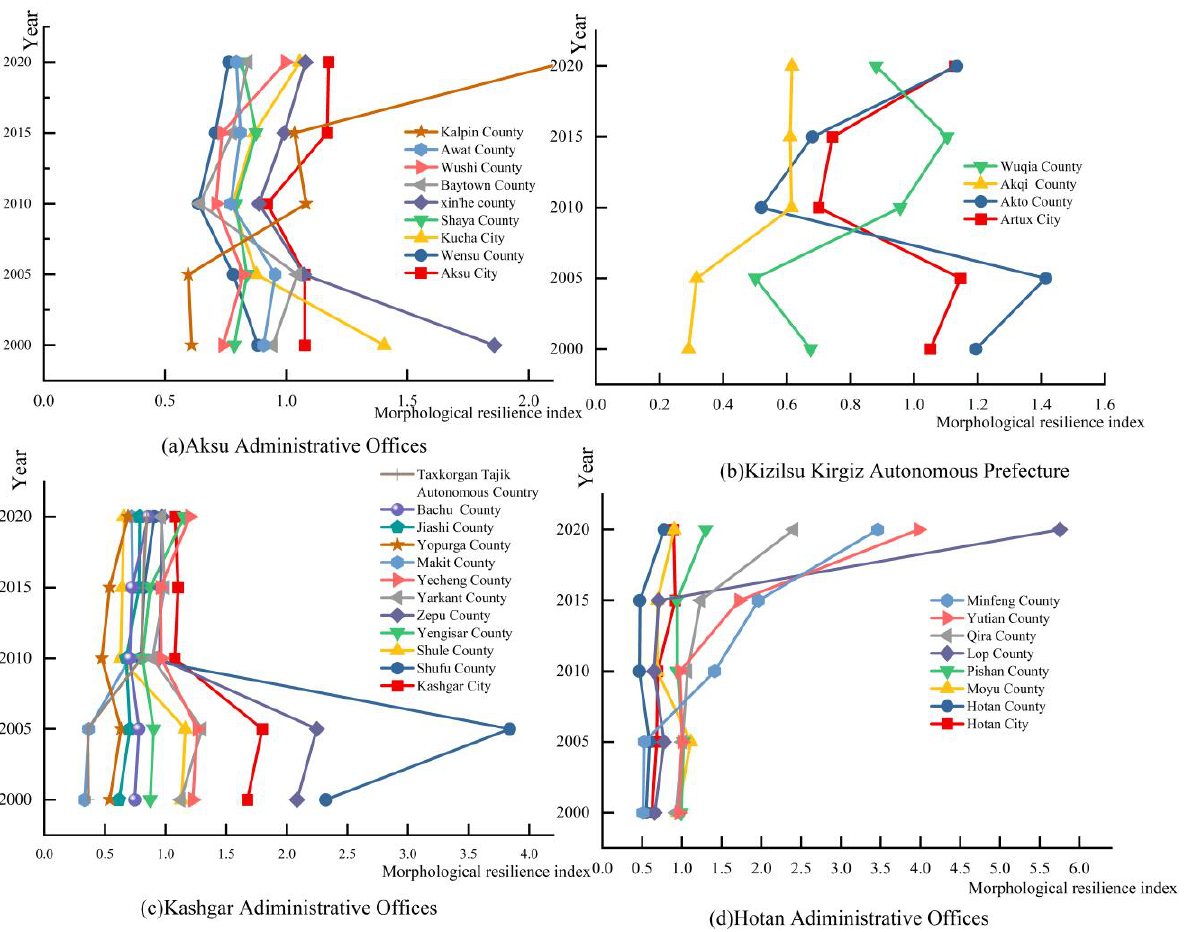
Figure 8. ( a ) Morphological resilience index of Aksu Administrative Offices from 2000 to 2020. ( b ) Morphological resilience index of Kizilsu Kirgiz Autonomous Prefecture from 2000 to 2020. ( c ) Morphological resilience index of Kashgar Administrative Offices from 2000 to 2020. ( d ) Morphological resilience index of Hotan Administrative Offices from 2000 to 2020.